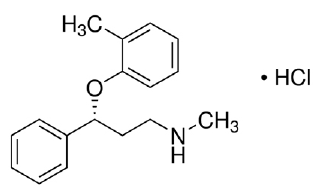
Fig 1. The chemical structure of atomoxetine hydrochloride Therefore, estimation of trace amounts of atomoxe- tine in various media is